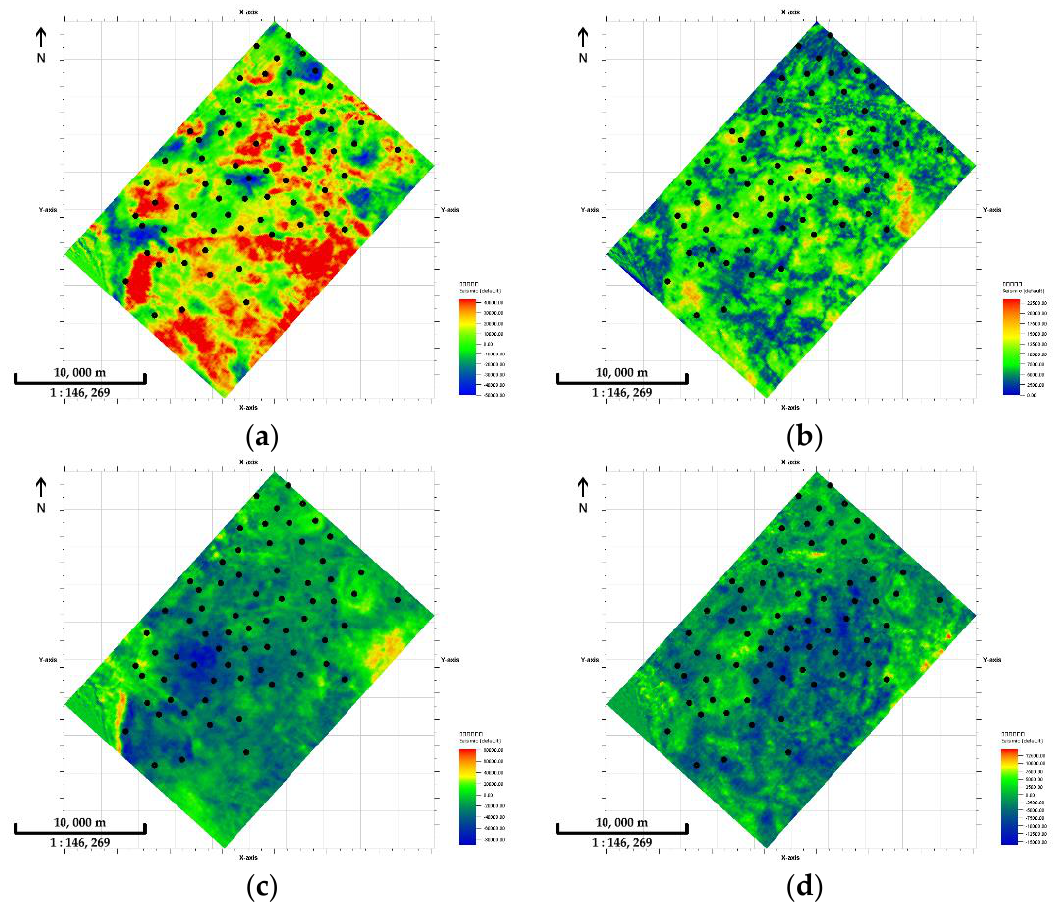
Figure 4. Seismic attribute data of the study area: ( a ) relative wave impedance; ( b ) root mean square amplitude; ( c ) hydrocarbon indicator; and ( d ) fluid factor.